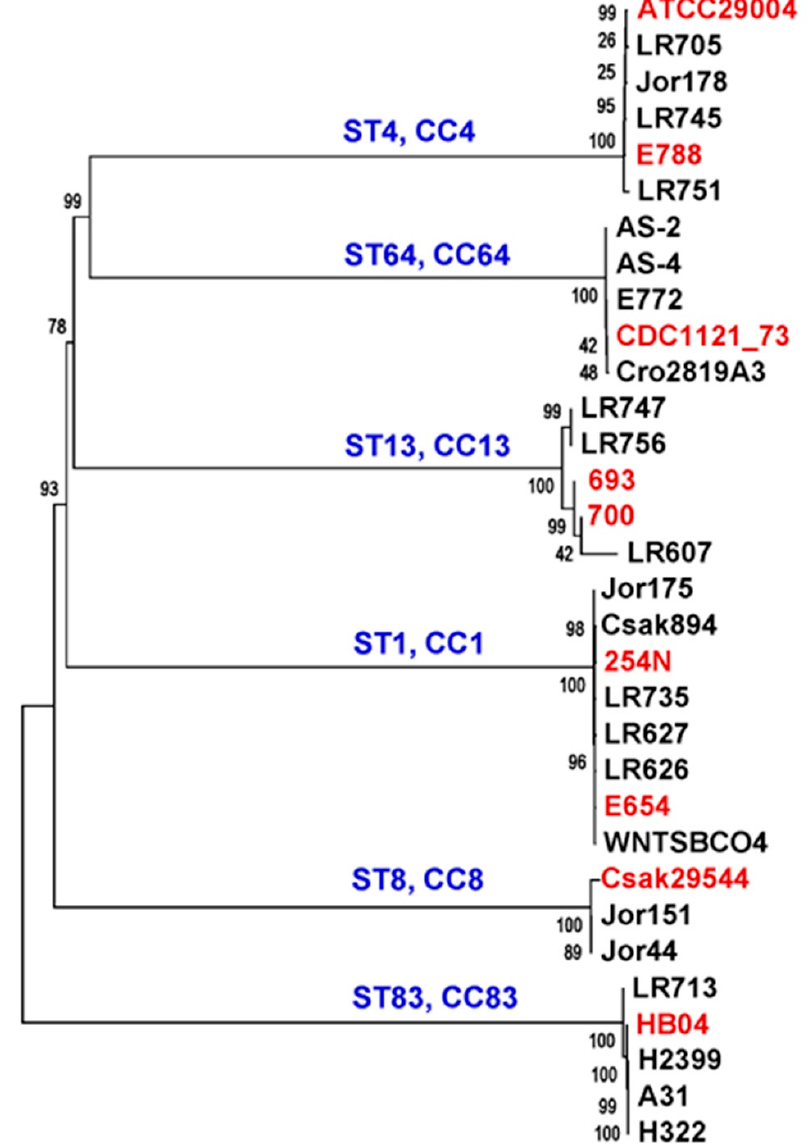
Figure 3. Co-clustering of plant-origin strains with clinical C. sakazakii genomes. Information of genomic properties of clinical strains used in the analysis is available in Supplemental Table S1. The initial allele matrix was used to identify clinical near-neighbors of plant-associated C. sakazakii . A representative group of isolates belonging to six STs is given where the red color indicates clinical strains. Blue font indicates ST and CC lineages.